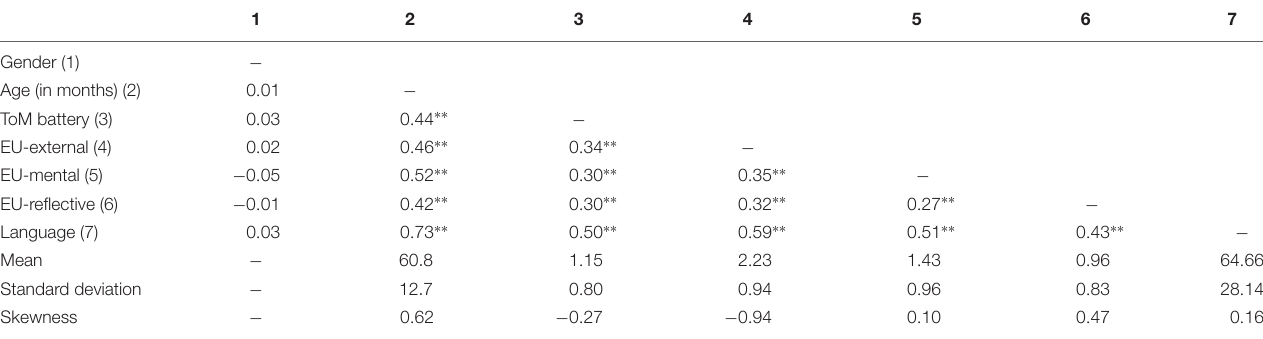
TABLE 1 | Means, standard deviations, skewness, and zero-order correlations for the investigated variables. 1